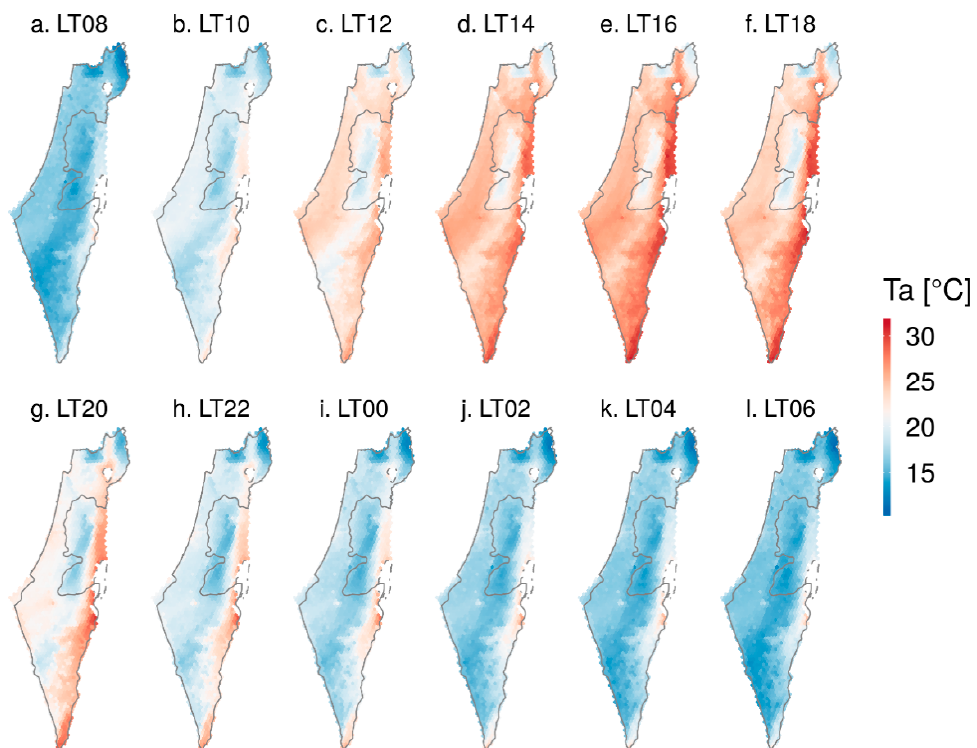
Figure 12. Multi-annual mean of estimated Ta at 4 km resolution from Stage 2 at two-hour intervals.